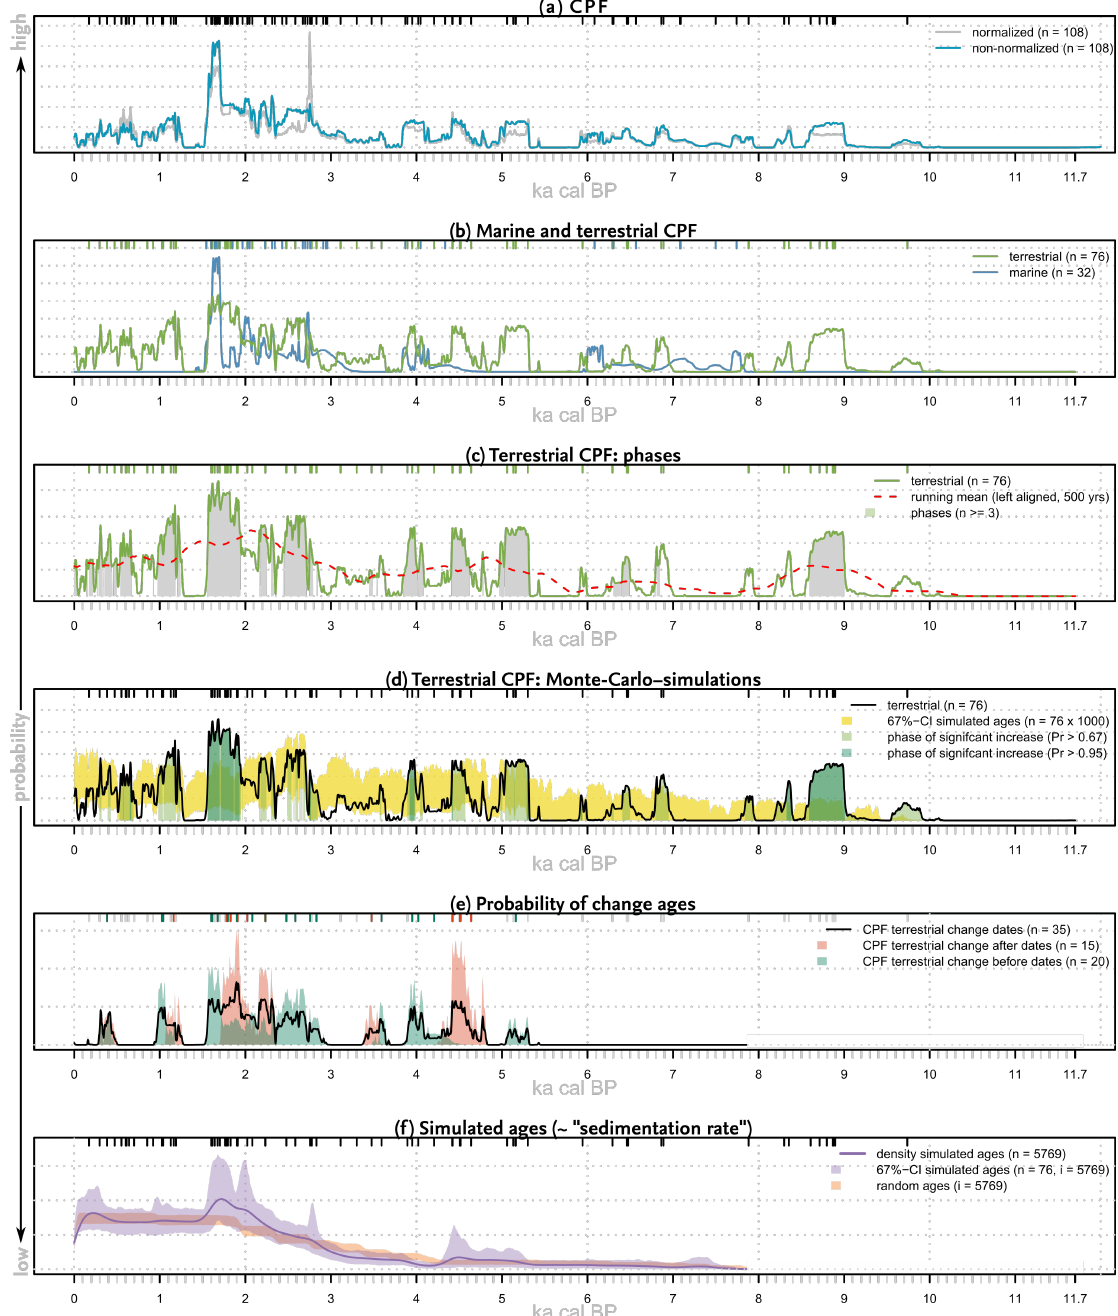
Figure 3. Cumulative probability functions and data from the null model calculated on the basis of different settings. Average normalized data of different archaeological periods are displayed in Figure 6. Stripes on the upper part of each plot show the median age of the relevant ages. The x-axis of all graphs show probabilities ranging from low to high. CI = confidence